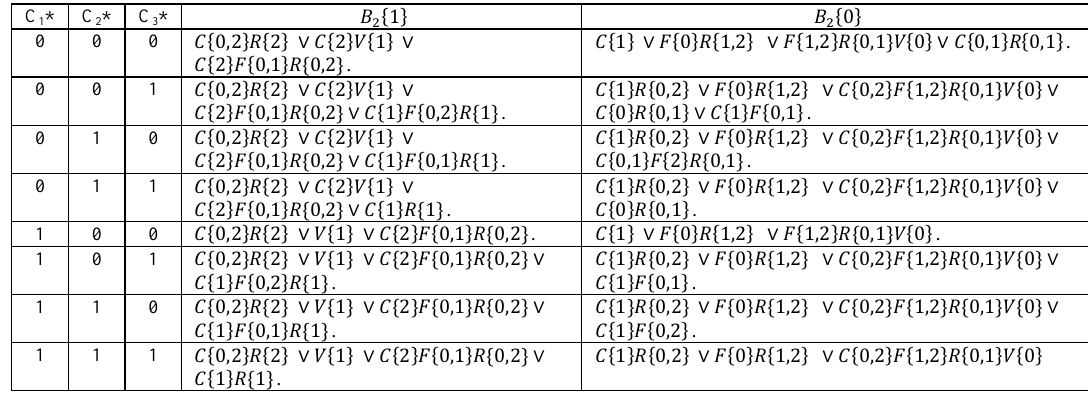
{1} and 𝐵 {0} for the eight possible combinations of C 2 2 C 2 * and C 3